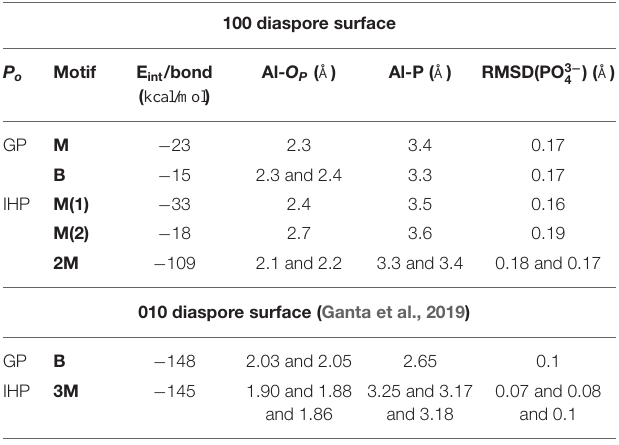
TABLE 1 | The per bond time averaged interaction energies (calculated with Equation 1) of diaspore–IHP/GP complexes and some selected bond lengths and